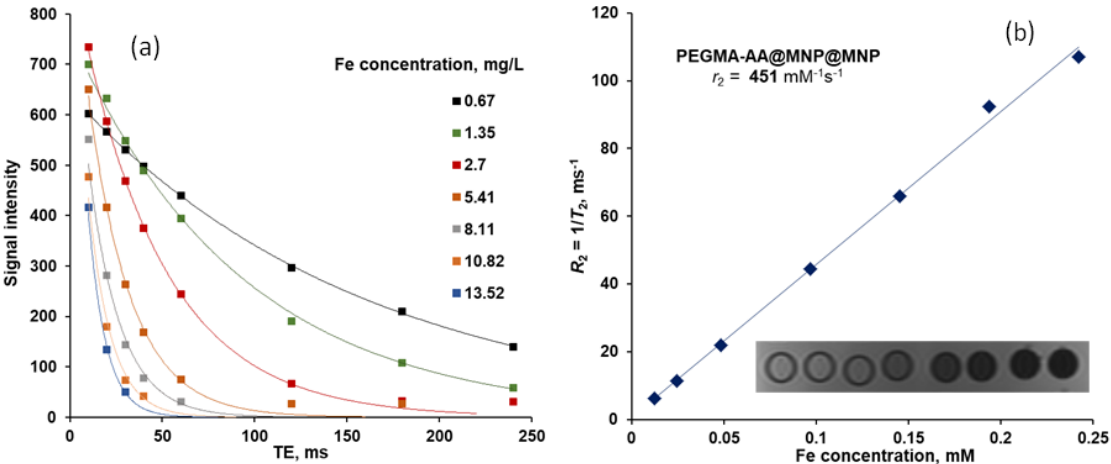
Figure 12. Transverse relaxation curves of P(PEGMA-AA)@MNPs in phantom water measured at 20 °C at increasing iron concentrations ( a ) and the plot for r 2 relaxivity vs. iron concentration ( b ). The goodness of the linear plot is R 2 = 0.9971. In the inset of the right panel, the T2-weighted image of the samples is shown (measured at TR = 3000 ms repetition time and TE = 40 ms echo delay time) with increasing Fe concentrations.